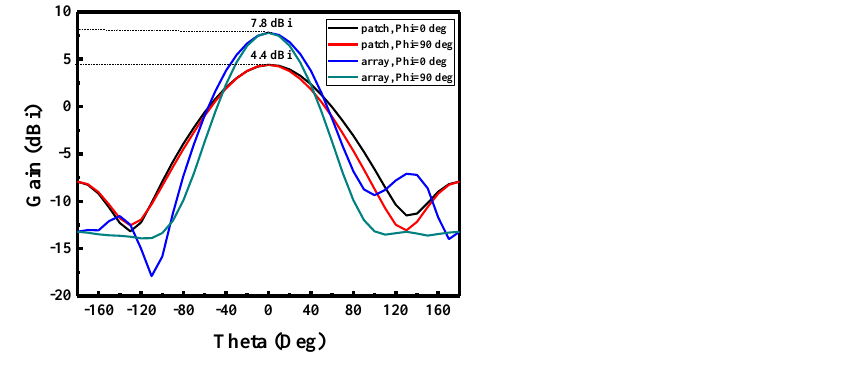
Figure 7. The gains of the single patch antenna and the patch antenna array.